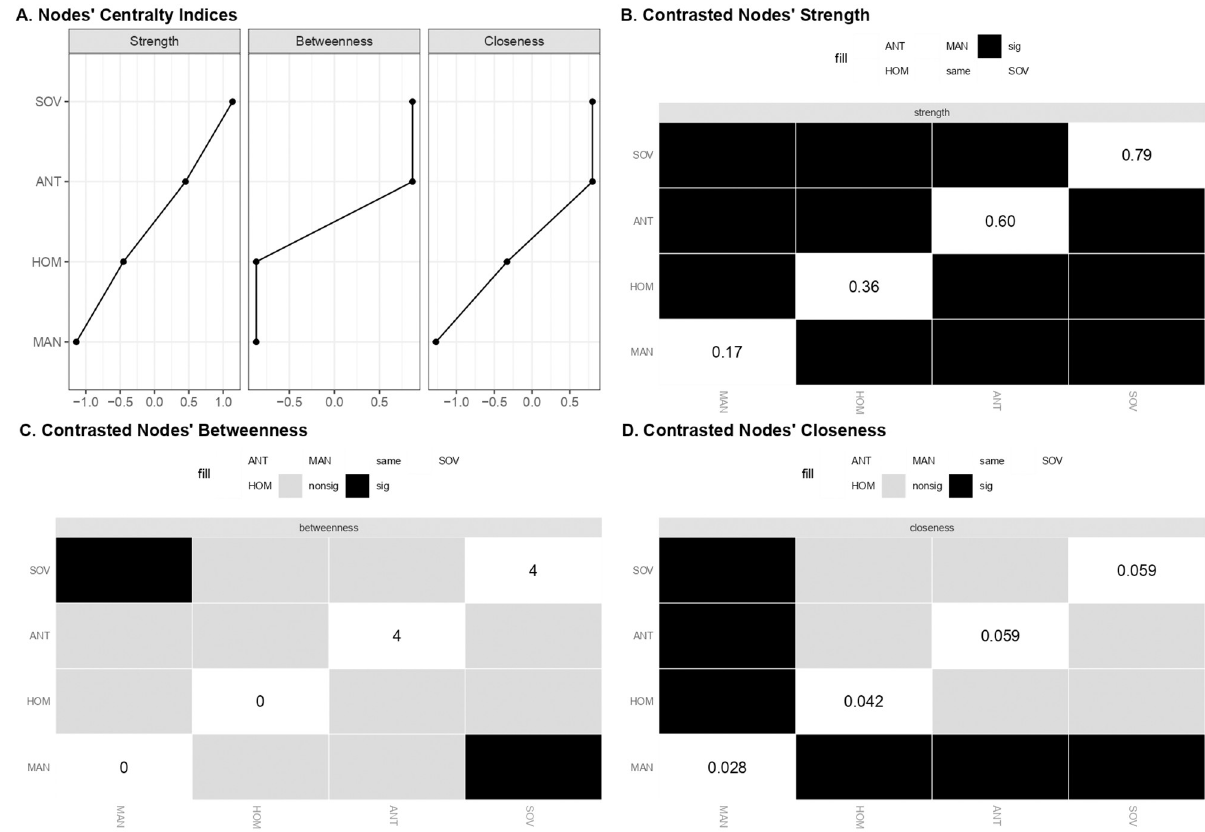
Fig 5. Estimates and bootstrap differences of centrality indices of the populist ideology dimensions network. (A) Standardized values of centrality indices for each populist ideology dimension. (B) Bootstrap differences between nodes for the strength centrality index. (C) Bootstrap differences between nodes for the betweenness centrality index. (D) Bootstrap differences between nodes for the closeness centrality index. Fig 5B-5D report sample estimates on the diagonal, while bootstrap differences in the black and gray boxes. Black boxes indicate significant differences based on bootstrap mean